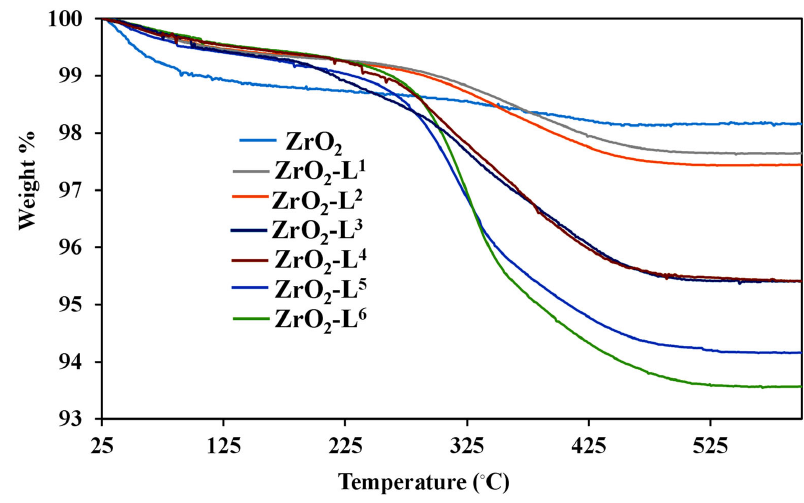
Figure 3. TGA curves of ZrO 2 and ZrO 2 ‐ L n samples. Table 2. Physico ‐ chemical properties of ZrO 2 ‐ L n nanomaterials.